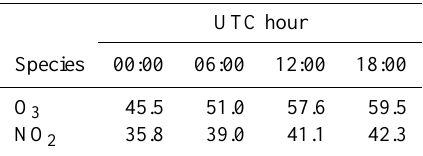
Table 1. Correlation length scales L (km) diagnosed from the NMC data set.